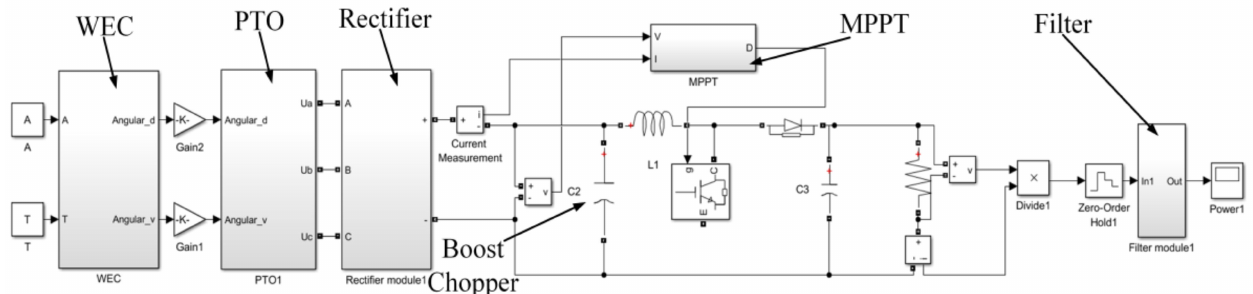
Figure 17. The diagram of simulation in Simulink, including WEC, PTO, rectification, filtering, and MPPT algorithm by